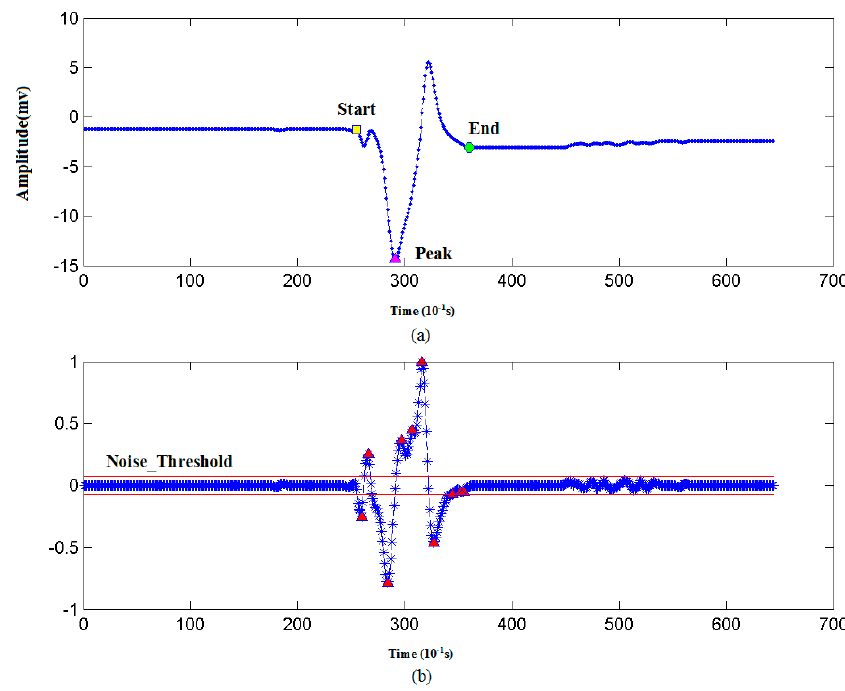
Figure 7. AP recognition process ( a ) Raw signal; ( b ) Derivative signal.